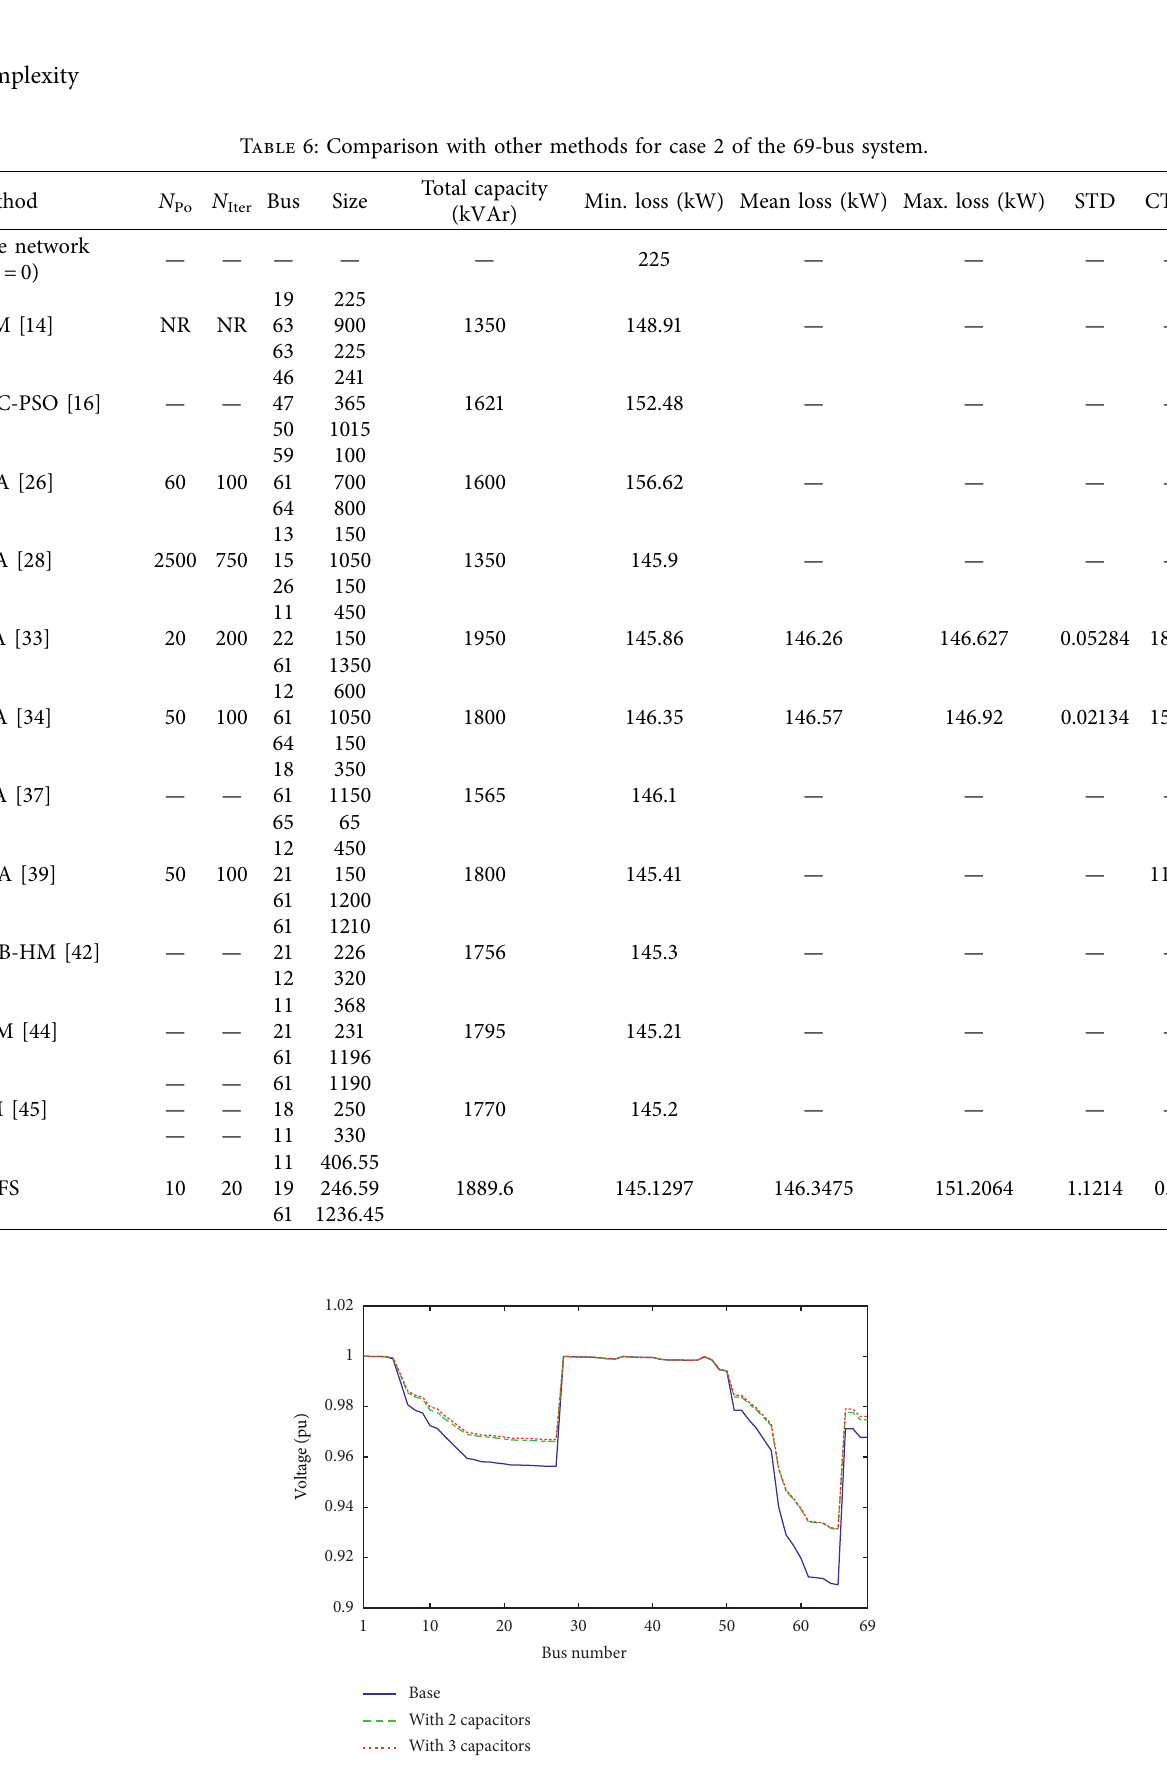
Figure 17: Voltage profile of the 69-bus network for different cases of capacitor